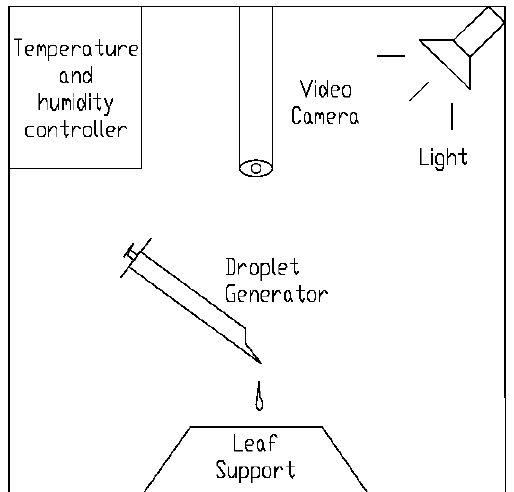
Figure 1. Diagram of the experimental setup. The testing devices were set inside a glass box, including a temperature and humidity control unit, a light supply, a leaf support and a video camera holder. Application of droplets could be seen through a window at the front of the box.